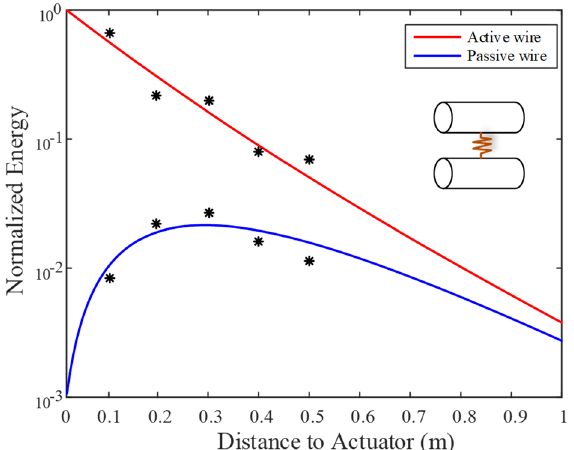
Figure 4. A model of the wave energy transfer between two adjacent wires. The results of the active wire are plotted by a red line, and the results of the passive wire are plotted by a blue line. The transient finite element (FE) simulation data of the two wires obtained in Section 3.2. are marked by asterisks.